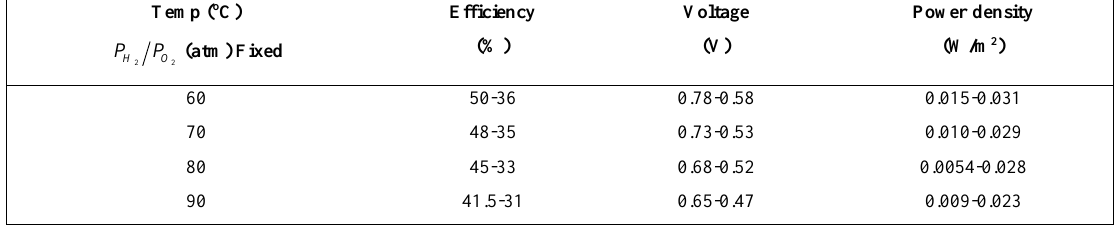
Table 6. PEMFC performance at constant reactants flow pressure and temperature